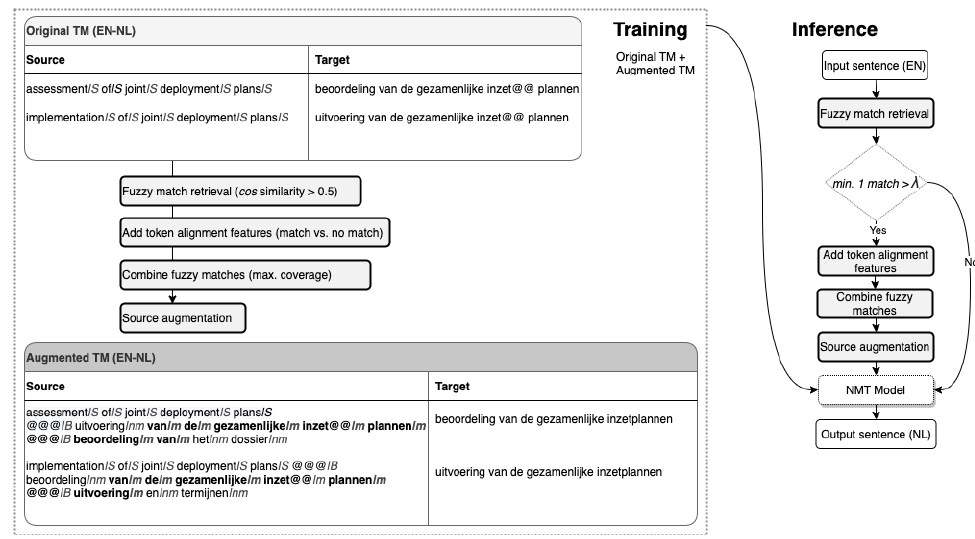
Figure 1. Neural fuzzy repair: training and inference. Table 2. Overview of the automatic evaluation